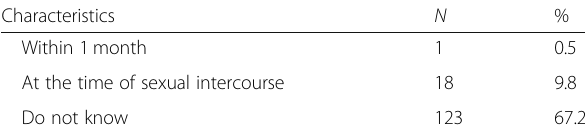
Table 2 Knowledge regarding the EC among the college students who had heard about the EC ( n = 183) (Continued) Characteristics